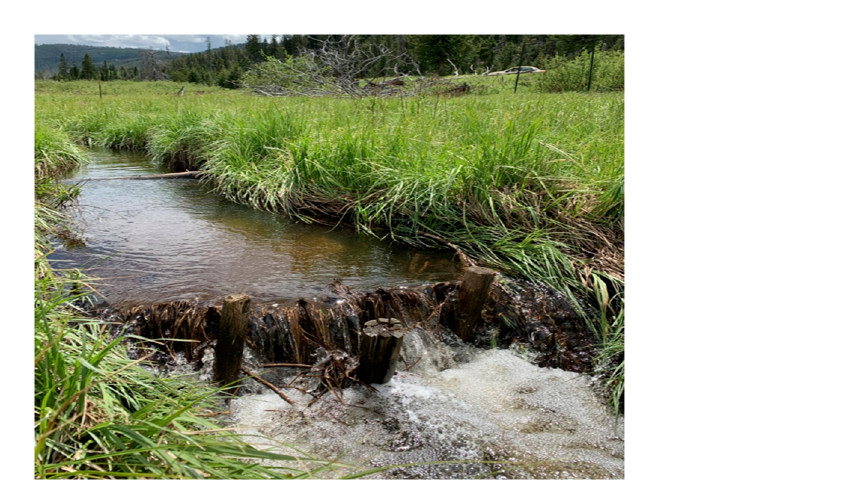
Figure 1. Study Reach Locations.